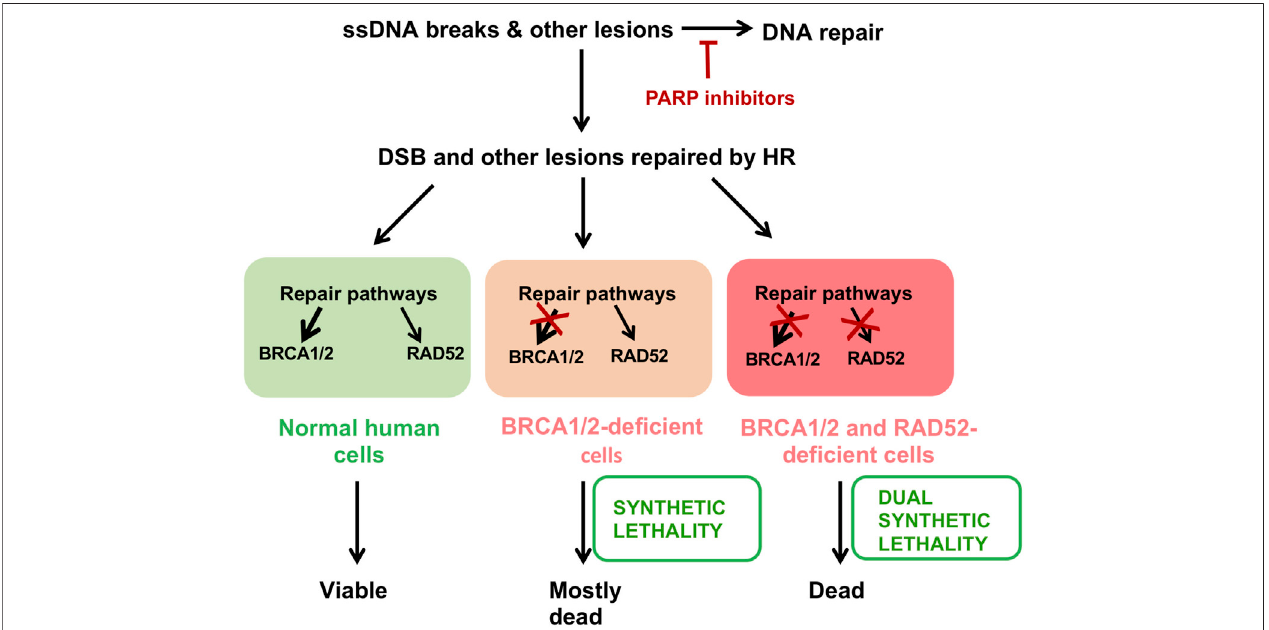
FIGURE4| Targetingcancercells via syntheticlethality. PARPinhibitors trapPARPonDNAlesionsandsuppress repairofssDNAbreaks.Thisleadstogeneration of DSBs and other lesions that can only be repaired by HR. Normal cells are capable of repairing these lesions. Dysfunction of BRCA1/2 and related genes cause synthetic lethality with PARP inhibitors so that most of these cells die. Selective pressure forces the cancer cells to become more dependent on alternative RAD52- dependent DNA repair pathways. A combinational treatment of PARP and RAD52 inhibitors enhances the ef fi cacy of each individual treatment via dual synthetic lethality and may cause a delay in the development of cancer drug